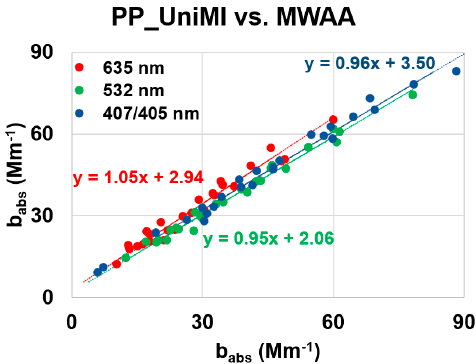
Figure 1. Scatterplot of the polar photometer PP_UniMI vs. Multi-Wavelength Absorption Analyzer (MWAA) measurements at comparable wavelengths. Deming regression lines are also represented.